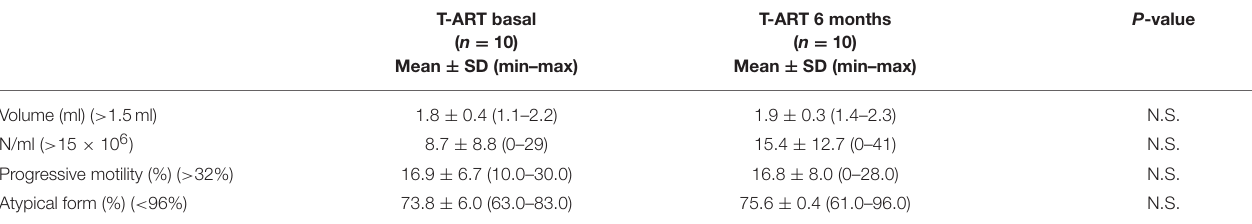
TABLE 3 | Semen parameters in patients with testicular adrenal rest tumor who repeated semen analysis after 6 months of modified glucocorticoid treatment.